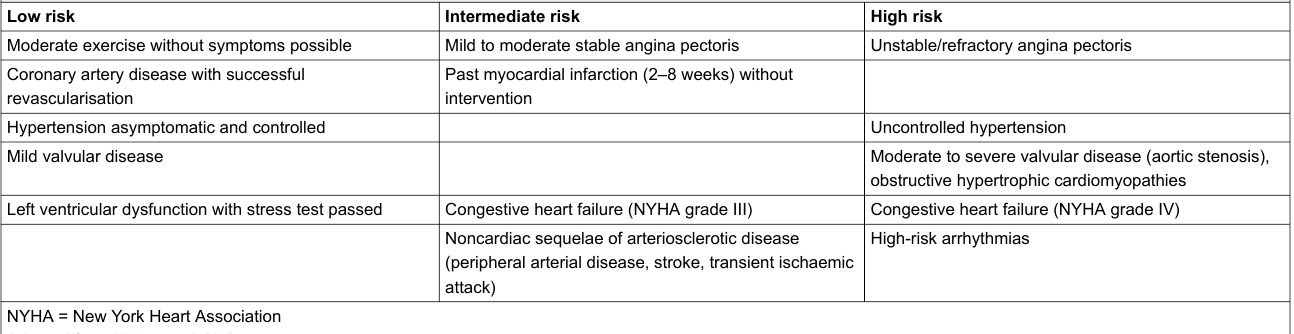
Table 2: Exercise ability and sexual activity risk stratification for patients with erectile dysfunction. Low